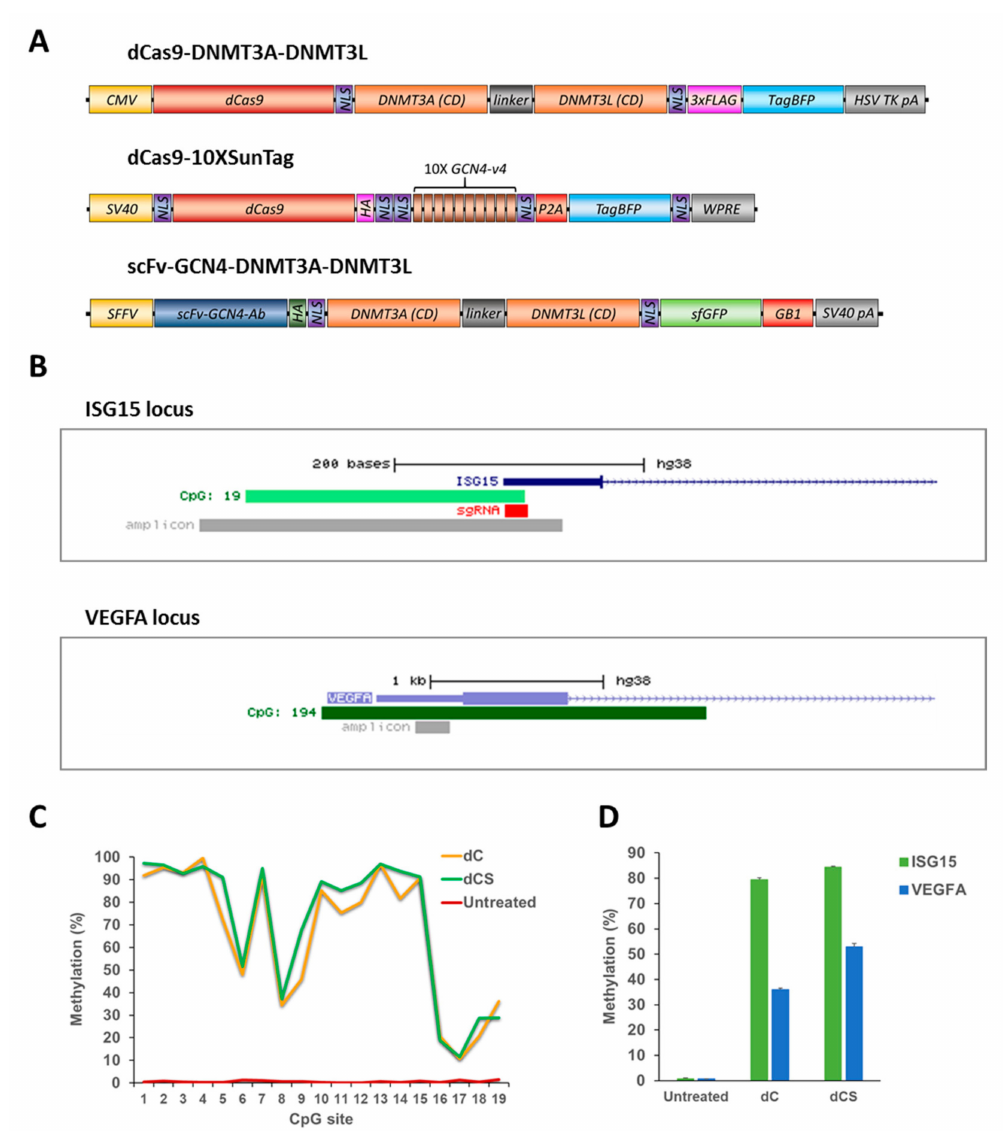
Figure 2. Comparison of the e ffi ciency and specificity of the dCas9-DNMT3A-DNMT3L direct fusion (dC) and dCas9-10XSunTag / Ab-3A3L (dCS) systems. ( A ) Schematic drawing of the direct and SunTag based systems used in the study. ( B ) UCSC genome browser views of the ISG15 (chr1:948671-948894, hg19) and VEGFA (chr6:43737633-43739852, hg19) promoter regions showing the localization of CpG islands (in light and dark green), amplicons used in targeted bisulfite sequencing (bis-seq), and sgRNA binding site within the ISG15 CGI. ( C ) DNA methylation of individual CpG sites (on the x-axis) at the ISG15 region determined by targeted bis-seq in untreated HEK293 cells and after treatment with the dC or dCS system using Ab-3A3L and the ISG15 sgRNA. Data from a single representative experiment are shown. ( D ) Average DNA methylation at the target ( ISG15 ) and o ff -target ( VEGFA ) regions were analyzed by targeted bis-seq of HEK293 in untreated cells and after targeted methylation with the dC or dCS systems. The figure shows the means of these average methylation levels based on two independent experiments and the standard deviations of the means. See also Figure